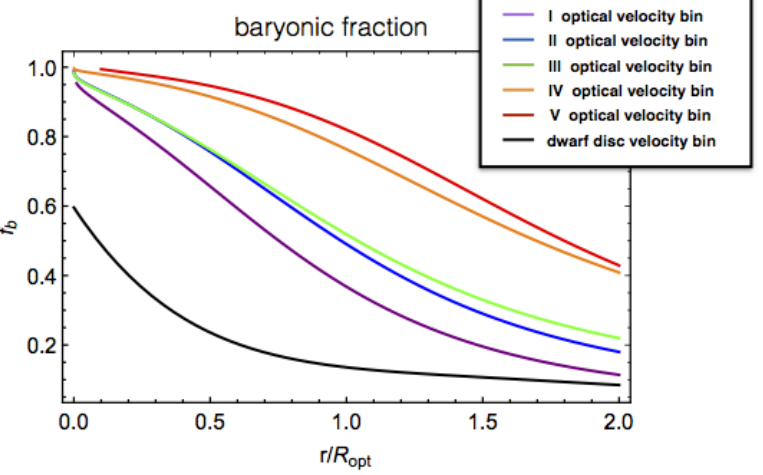
Figure 19. Baryonic fraction ( V b / V ) 2 as a function of r / R opt derived from the URC-dd (black line, with (cid:104) V opt (cid:105) = 40 km/s) [30] and from the LSB-URC ([38]) evaluated at the < V opt > values. Image reproduced from